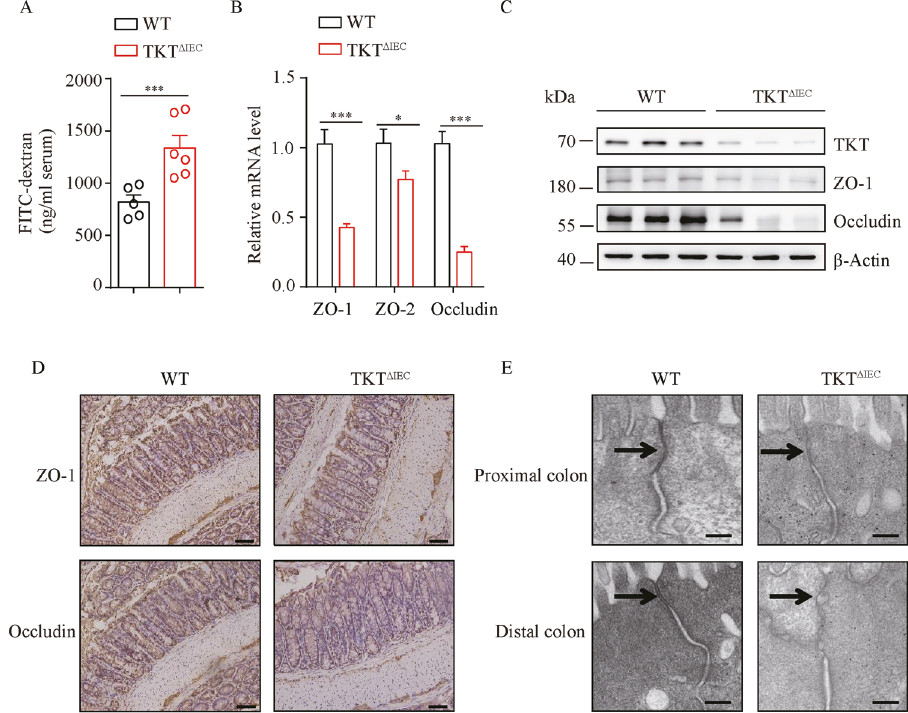
Fig. 4 IEC TKT deletion disturbs barrier function of intestines. A Intestinal permeability was measured by determining the concentration of FITC-dextran in blood serum ( n = 5 for WT mice, n = 6 for TKT Δ IEC mice). B QPCR analysis of the expression of genes related to tight junction in colons ( n = 7 for WT mice, n = 9 for TKT Δ IEC mice) from 8-week-old WT and TKT Δ IEC mice. C Western blotting analysis of proteins in colon lysates from 3-week-old WT and TKT Δ IEC mice ( n = 3). D Representative images of colon sections stained with the indicated antibodies from 8-week-old WT and TKT Δ IEC mice. Scale bars, 50 μ m. E Electron micrographs of intestinal epithelial cells from proximal colon (top row) and distal colon (bottom row) of WT and TKT Δ IEC mice showing the tight junction structures. Arrows point to tight junction membrane kisses which were disrupted in TKT Δ IEC mice. Scale bars, 200 nm. Data are represented as mean ± SEM. Signi fi cance is determined by Student ’ s t test analysis, * P < 0.05, ** P < 0.01, *** P <